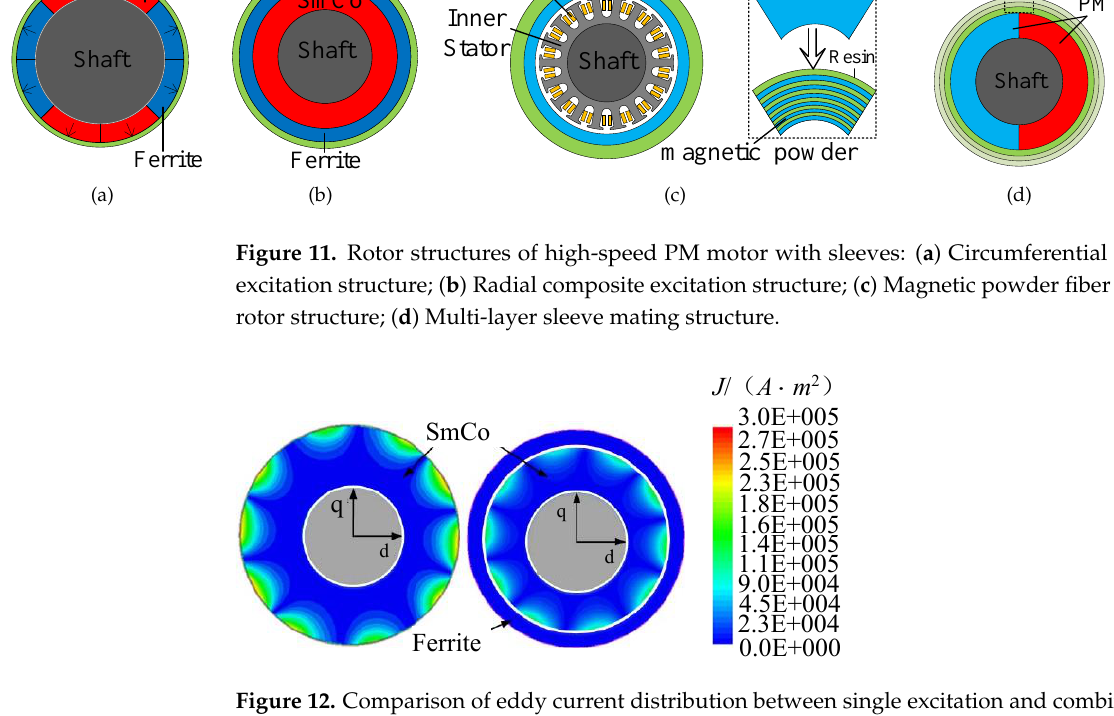
Figure 12. Comparison of eddy current distribution between single excitation and combined excita- tion